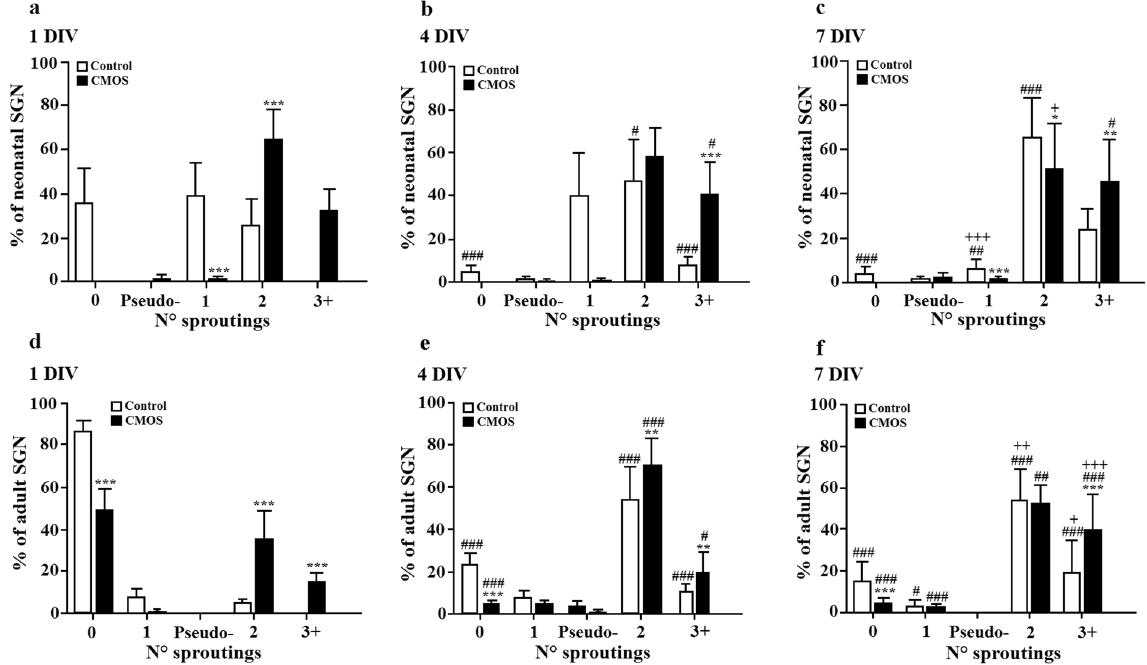
Figure 4. The effect of CMOS chip on neonatal and adult SGN neuronal morphology. The upper row shows data for neonatal, the lower for adult SGN, while columns separate data based on DIV time. ( a ) Quantification of neonatal SGN neuronal morphology on control and chip substrates after 1 DIV, ( b ) after 4 DIV and ( c ) after 7 DIV where N° indicates the number of sproutings (0 = neurite-free, 1 = monopolar, 2 = bipolar, 3 + = multipolar). Significant differences are indicated by # for differences by 1 DIV: # P < 0.05, ## P < 0.01, ### P < 0.001 (one-way ANOVA, Tukey post-hoc test), by + for differences by 4 DIV: + P < 0.05, ++ P < 0.01 and +++ P < 0.001 (one-way ANOVA, Tukey post-hoc test) and by * for differences between the control and CMOS substrates: * P < 0.05; ** P < 0.01, *** P < 0.001 (Student’s t-test). ( d ) Quantification of adult SGN neuronal morphology on control and chip substrates after 1 DIV, ( e ) after 4 DIV and ( f ) after 7 DIV. Significant differences are indicated by # for differences by 1 DIV: # P < 0.05 and ### P < 0.001 (one-way ANOVA, Tukey post-hoc test), by + for differences by 4 DIV: + P < 0.05, ++ P < 0.01 and +++ P < 0.001 (one-way ANOVA, Tukey post-hoc test) and by * for differences between control and CMOS substrates: ** P < 0.01, *** P < 0.001 (Student’s